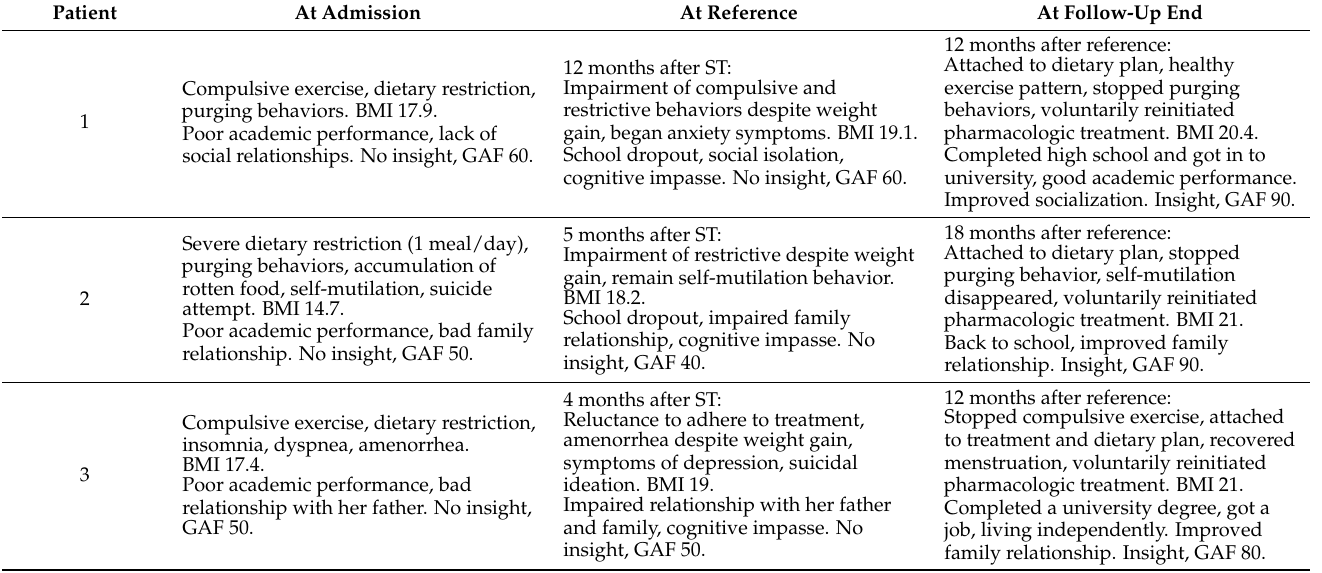
Table 1. Clinical picture of patients at three